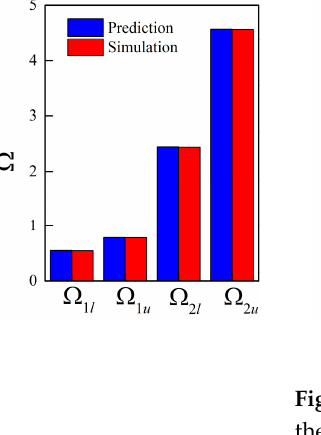
Figure 4. Correlation between the bounding frequencies obtained by the NN and TMM models for the forward design of micro-PnC beams ( a ) incorporating size effects and ( b ) without size effects; ( c ) random examples of band gap characteristics predicted by NNs considering the length scale pa- rameter and ( d ) NNs excluding the length scale parameter. The red column denotes the ground truth of band gaps. Table 3. Random designs of material properties for the micro-PnC beam.